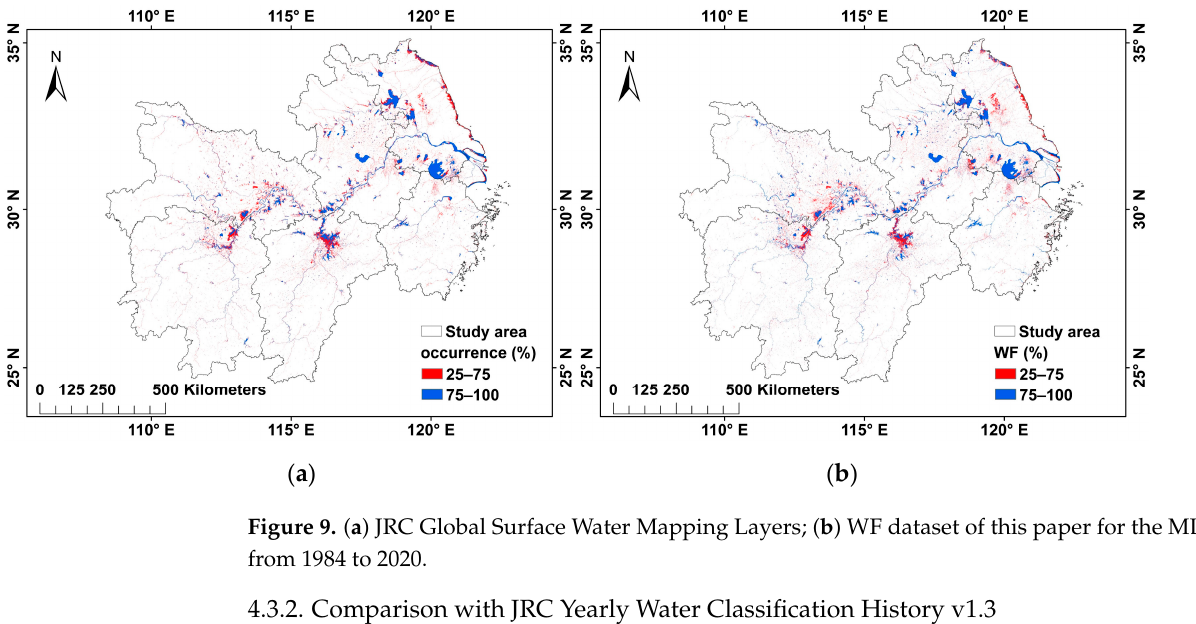
Figure 11. ( a ) JRC yearly water classi fi cation historical data; ( b ) WF year data of this paper for the MLYP in 1998. 4.4. Limitations and Future Improvements In this study, we used Landsat data to produce a dataset of water bodies in MLYP with a 30 m spatial resolution and 36-year temporal resolution, which fi lls the gap in the JRC data for the water bodies in the region in the 1980s and 1990s. Through the water frequency, we were able to analyze the inter- and intra-annual trends of the water bodies, but the MLYP has high rainfall in the summer and the water bodies change seasonally and can even change rapidly between di ff erent months. Moreover, in the summer, the clouds are thick, and, as Landsat images are easily a ff ected by clouds, this limits the real-time high-frequency monitoring of open-surface water bodies when extreme precipitation oc- curs, resulting in inaccurate results. This problem is solved by adding other data for the study of multi-source remote sensing spatial and temporal fusion, such as MODIS, with a daily temporal resolution, Sentinel-1 synthetic aperture radar (SAR), Sentinel-2, GF, Planet and other high-resolution data, especially SAR images, which can penetrate clouds and can be used in cloudy weather. The method of extracting water bodies explored in this paper can be used for three typical areas in the MLYP, but, as mentioned above, the water bodies in this area have large intra-annual variation and using an annual-scale impervious surface to remove the building noise will cause the water body results to be inaccurate. However, the water body index method alone cannot extract water bodies on complex features. Yang et al. used GHSL [14] data to calculate water bodies individually for natural areas and built-up areas,